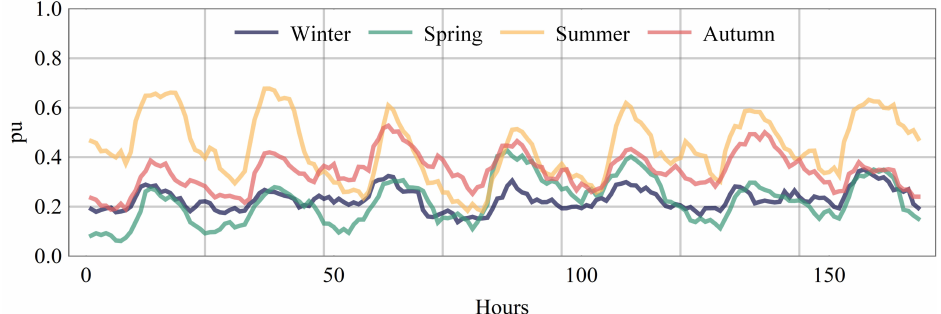
Figure 5. Estimated wind generation for sample weeks of winter, spring, summer, and autumn, in per unit.